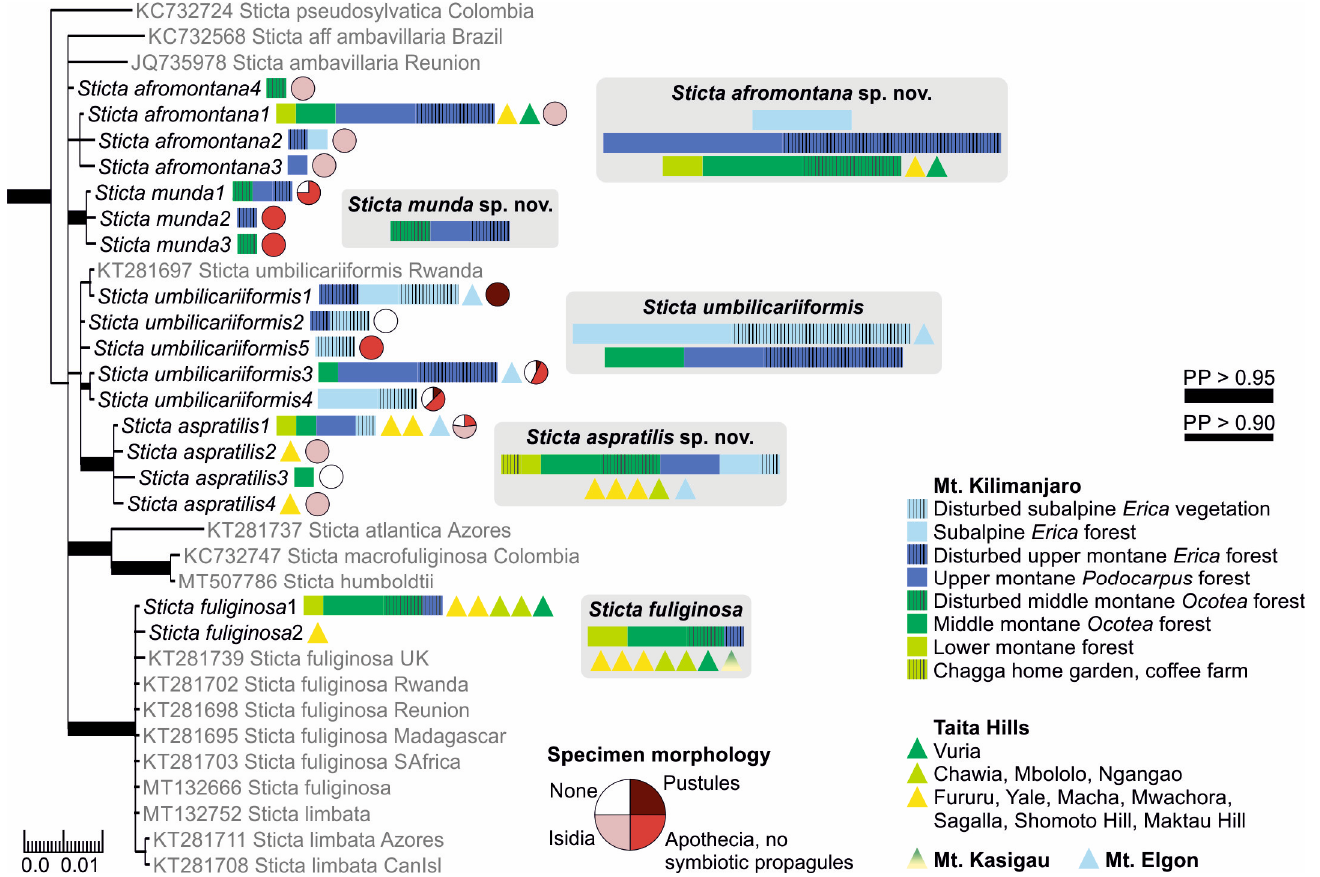
the distribution of the ITS variants in the studied regions and ecosystem types: On Mt. Kilimanjaro, the different habitats are indicated by color and grid; the width of the rectangle indicate the number of sample plots in which the taxon was present in each ecosystem type (square = 1). In the Taita Hills, each triangle indicates presence in one forest fragment and on Mt. Kasigau in one sampling transect. The grey boxes show the total abundance and distribution of the species, also including the data from unsequenced specimens. Stronger support (PP > 0.9) for a clade is indicated with a thicker branch. The scale refers to nucleotide substitutions per site.